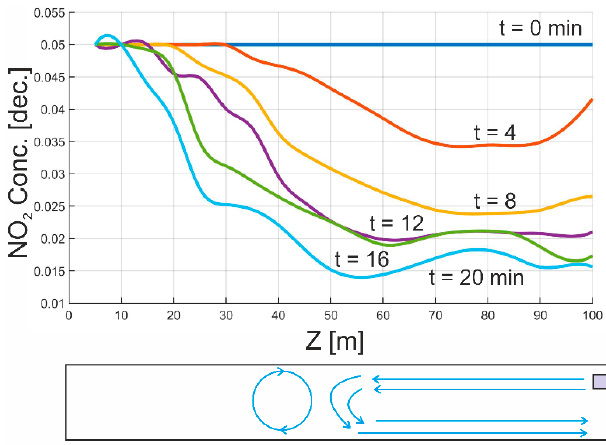
Figure 13. Concentrations of NO 2 inside the dead end for different ventilating times. The data correspond to scenario 4 and an air velocity of 20 m / s at the duct inlet.